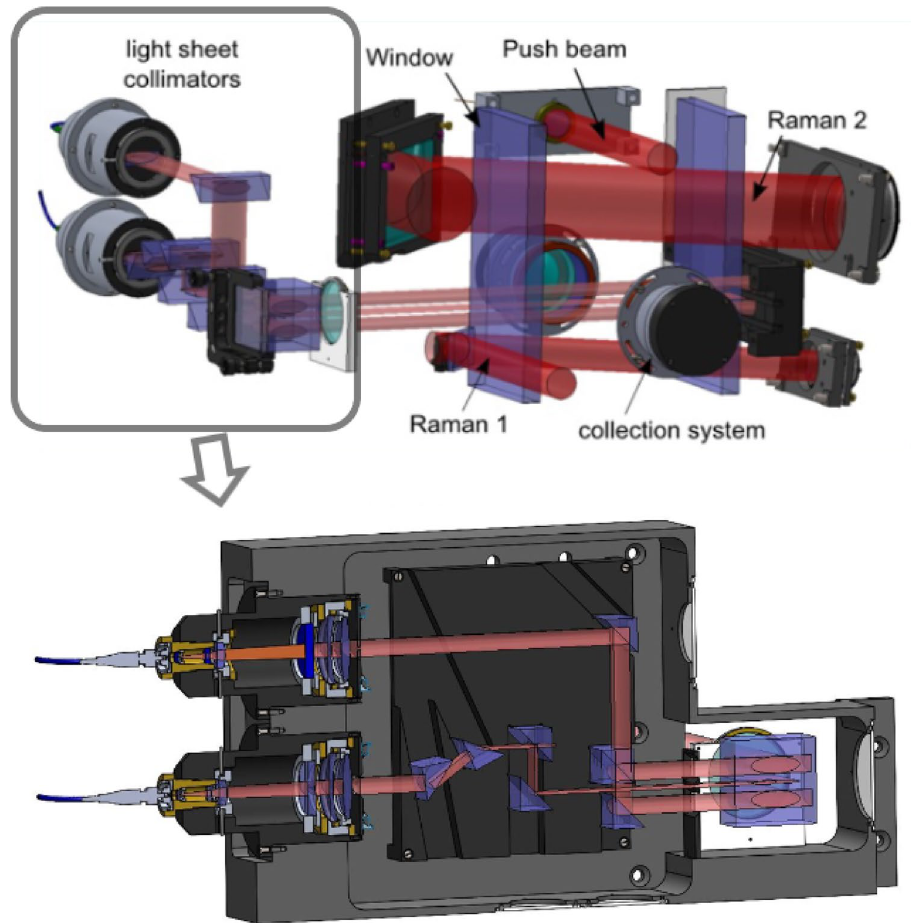
Figure 5. CAD drawing of the atomic preparation and detection system. The bottom panel shows how the 3 elliptical light sheets used for the detection are produced from the light originating from two elliptical collimators.